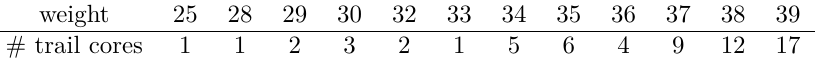
Table 1: Trail core weight histogram for 3 rounds of Subterranean. We report only on the number of trail cores that are different modulo translation: each unit in this table corresponds to 257 trail cores.